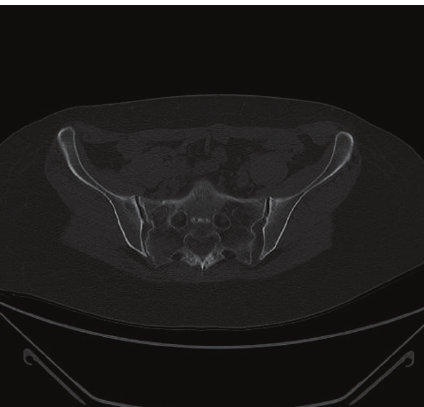
Figure 1: MRI T2 axial scan showed bone marrow edema at the sacrum.